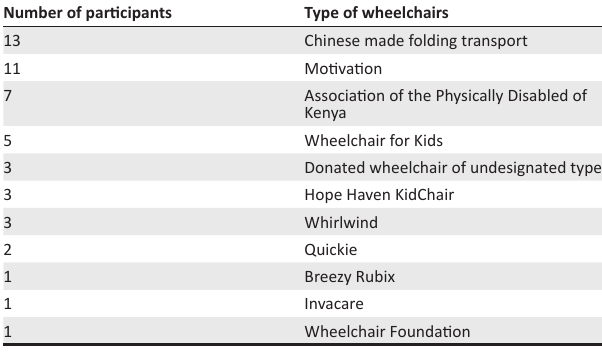
TABLE 1a: Types of wheelchairs as provided by the host organisation. Number of participants